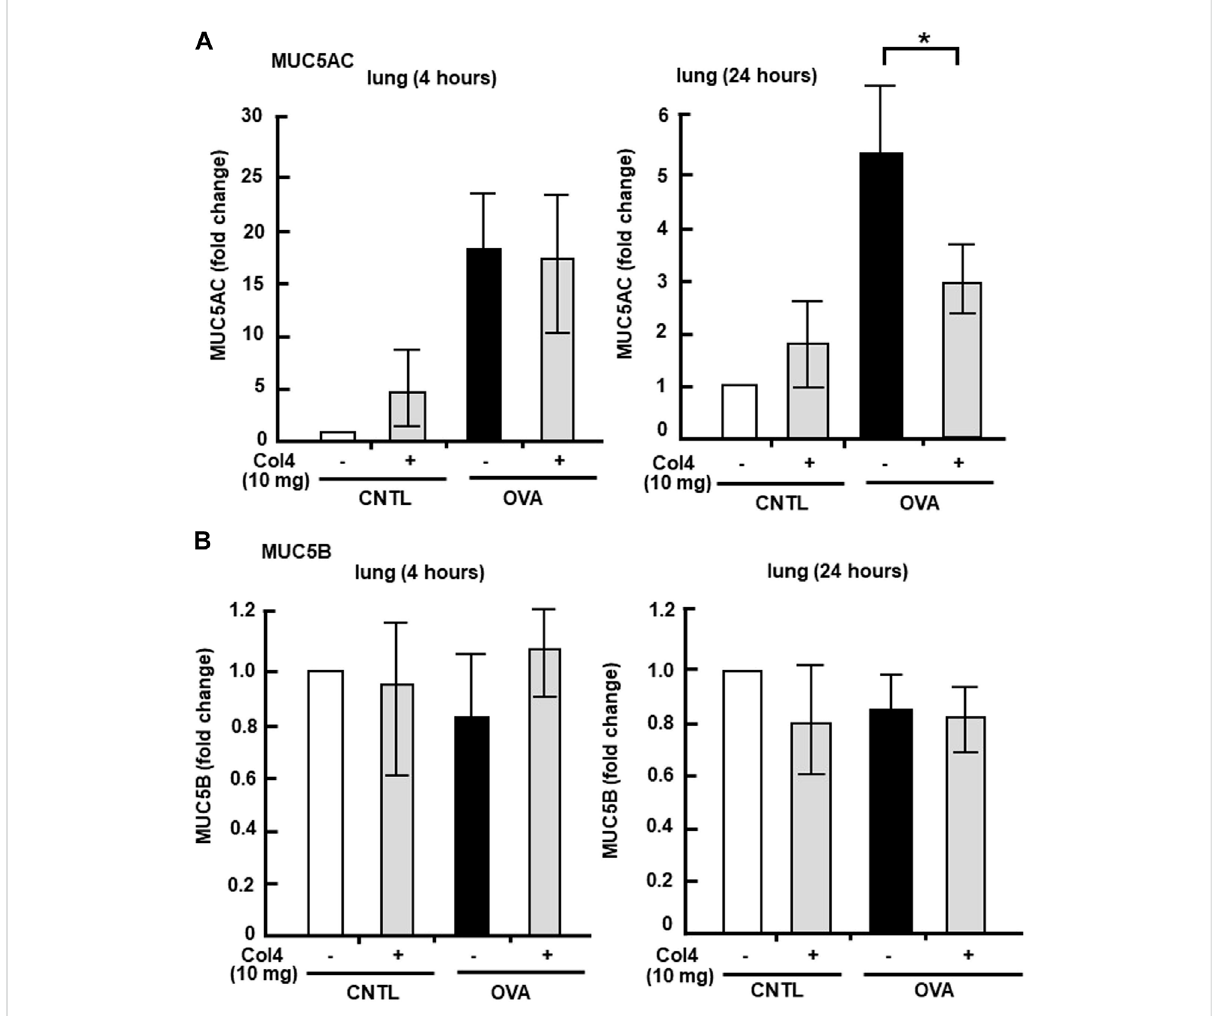
FIGURE 5 EffectsofCol4oncellularmucin5AC(MUC5AC)andmucin5B(MUC5B)levelsinovalbumin(OVA)-sensitizedmic. (A) TheOVA-sensitizedmice wereexposed toCol4 (10 mg).After 4and24 hofCol4 exposure, MUC5AC levels inbronchoalveolarlavage fl uid(BALF)or lungtissue sampleswere detected using the dot-blot method and measured. (B) The OVA-sensitized mice were exposed to Col4 at various concentrations (0 – 10 mg). After 4 and 24 h of Col4 exposure, MUC5B levels in BALF or lung tissue samples were detected using the dot-blot method and measured. The MUC5AC and MUC5B protein levels in lung tissue samples were normalized to the GAPDH levels before analysis. The control mice and the mice treated with 0 mg of Col4 were exposed to PBS alone at the same time. Fold changes were based on the ratio between the values[mean ± standard deviation (SD), n = 5]. A one-way analysis of variance was used to obtain the p -values. Asterisks indicate statistical signi fi cance, * p < 0.05. Representative results of three independent experiments are